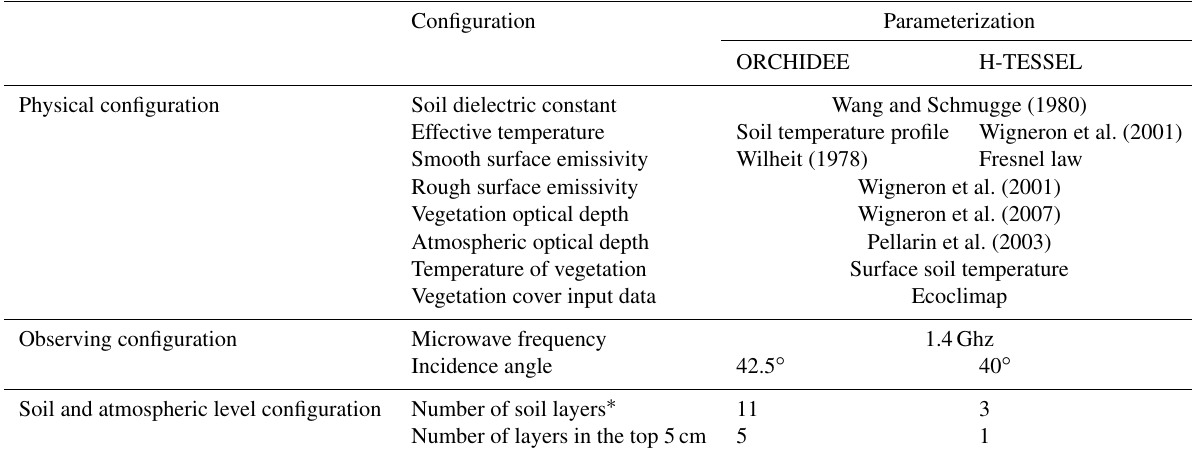
Table 1. CMEM configuration for the two sets of modelled TBs.